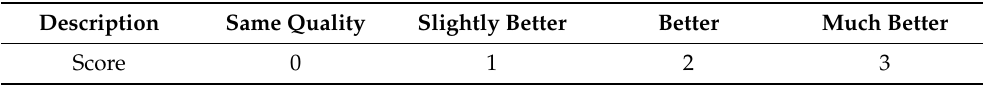
Table 3. Evaluation standard for subjective quality